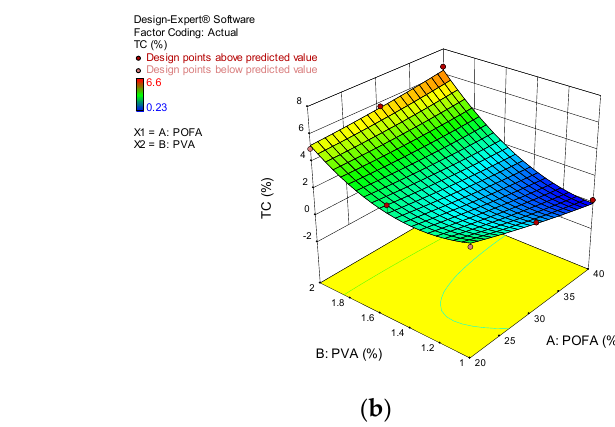
Figure 22 . ( a ) 2D Contour Plot and ( b ) 3D Response Surface Diagram for Flexural Strength.